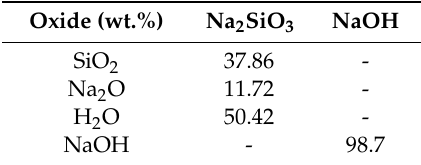
Table 2. Chemical composition of sodium silicate (Na 2 SiO 3 ) and sodium hydroxide (NaOH) that were obtained by chemical analysis and provided by the manufacturer, respectively.